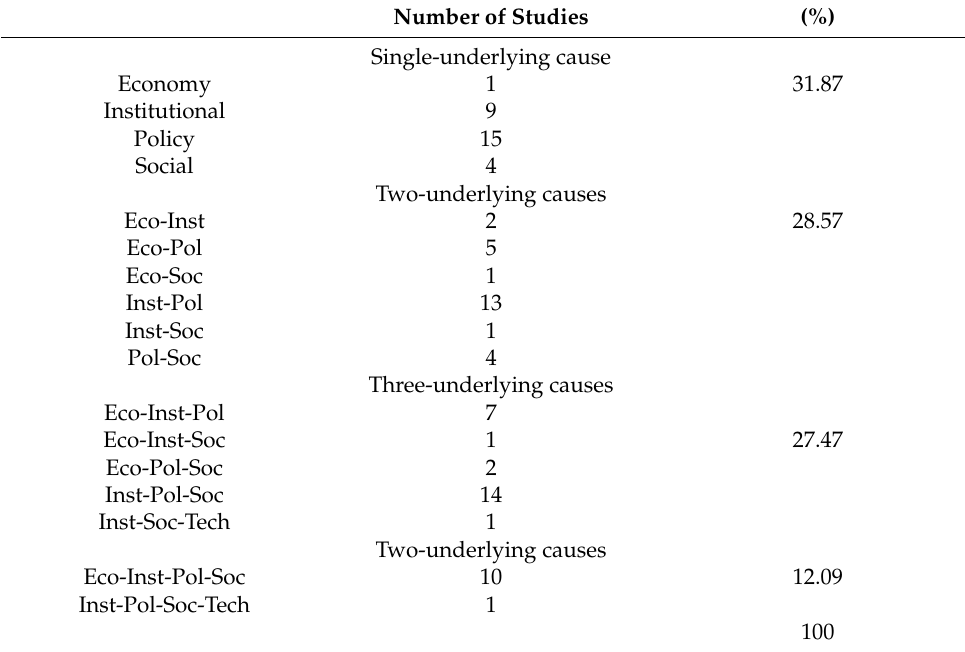
Table A7. The proportion of the combined causes of land